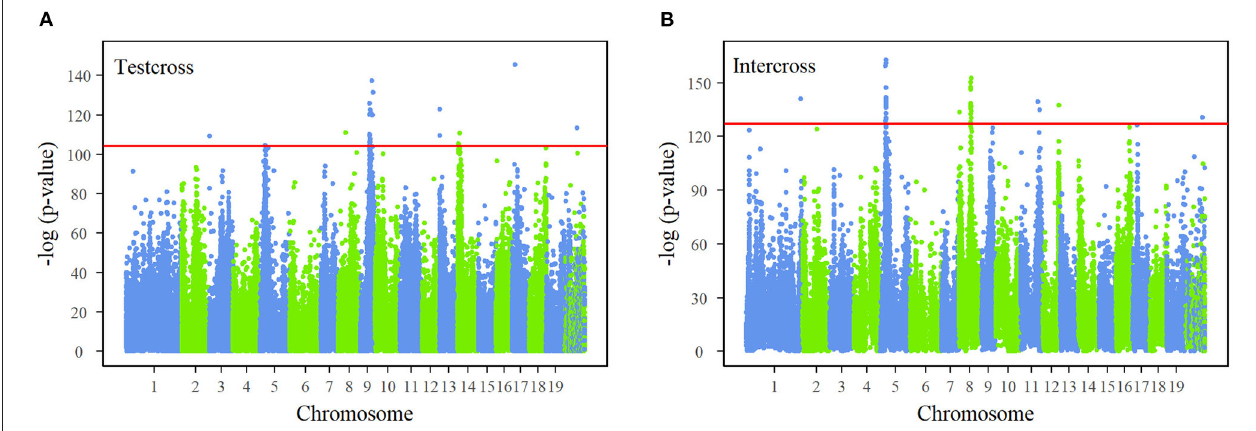
FIGURE 2 | Manhattan plots of p -values across 19 chromosomes of the Populus genome. Test statistic values of single-nucleotide polymorphisms (SNPs) were calculated by the system mapping of 24-yr growth curves of stem height and diameter. The p -values are obtained after false discovery rate (FDR) correction. Red horizontal lines are the critical thresholds at the 10 − 40 and 10 − 50 significance levels for (A) test cross SNPs and (B) intercross SNPs obtained by Bonferroni correction.